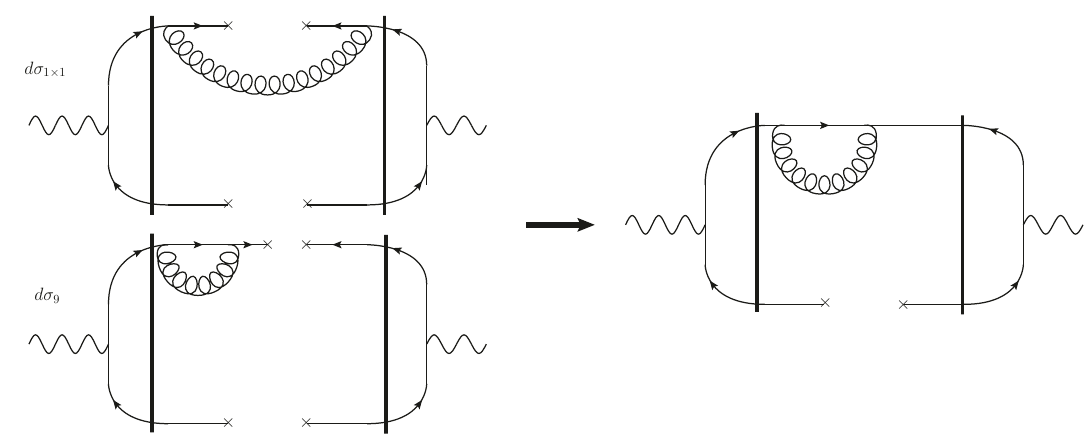
Figure 3 . When one integrates out the final state quark, the real correction σ 1 × 1 and the virtual correction σ 9 become the same diagram. Here the ‘x’ at the end of a solid line indicates produced quarks and antiquarks.